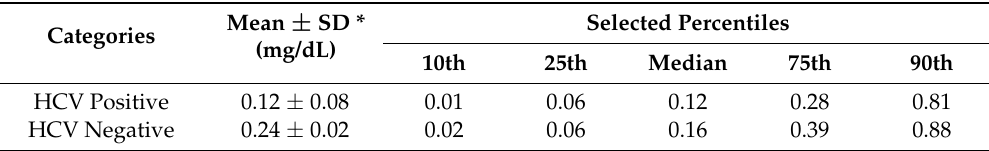
Table 2. Weighted mean and selected percentile of C-reactive protein (mg/dL by hepatitis C virus (HCV) status): National and Health Nutrition Examination (NHANES) 2009–2010. Mean ± SD * Selected Percentiles Categories (mg/dL) 10th 25th Median